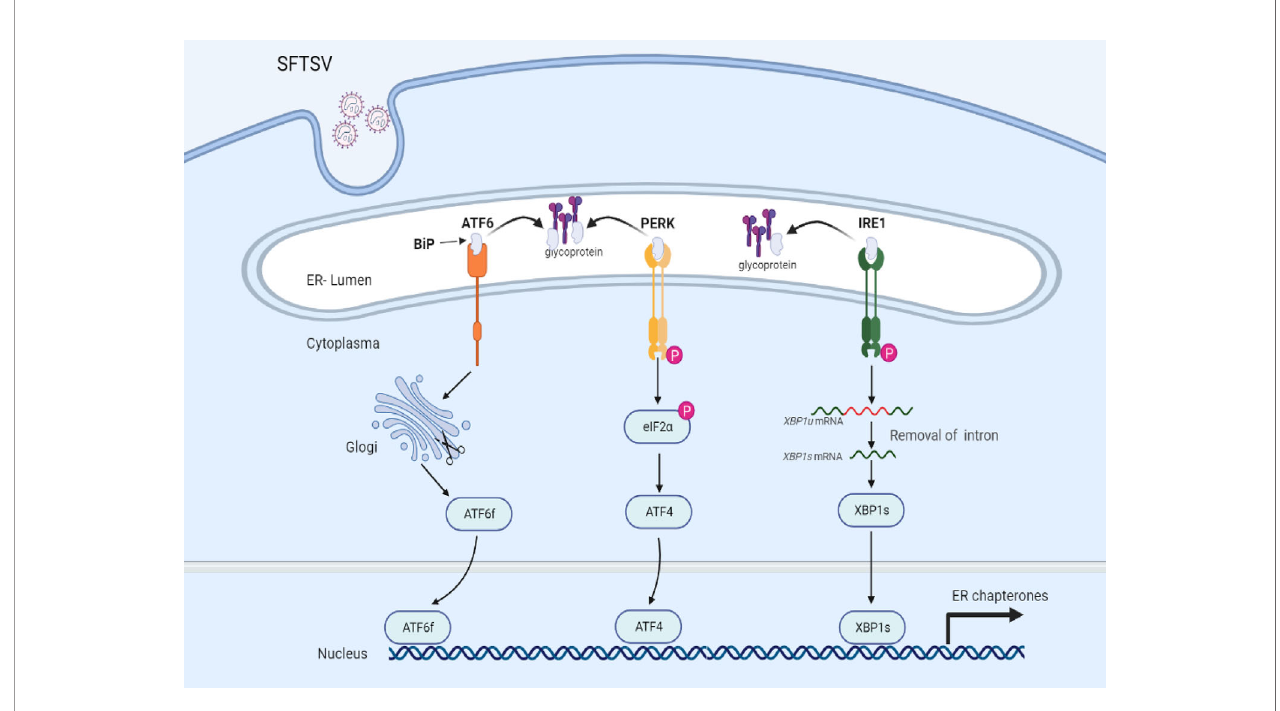
FIGURE 2 | UPR is mediated via SFTSV infection. Under a resting state, transmembrane proteins (ATF6, PERK, and IRE1) are bound with glucose-regulated protein 78 (BiP) maintaining inactive status. Upon SFTSV infection, SFTSV GP mediated the disassociation of BiP with transmembrane proteins, leading to the activation of